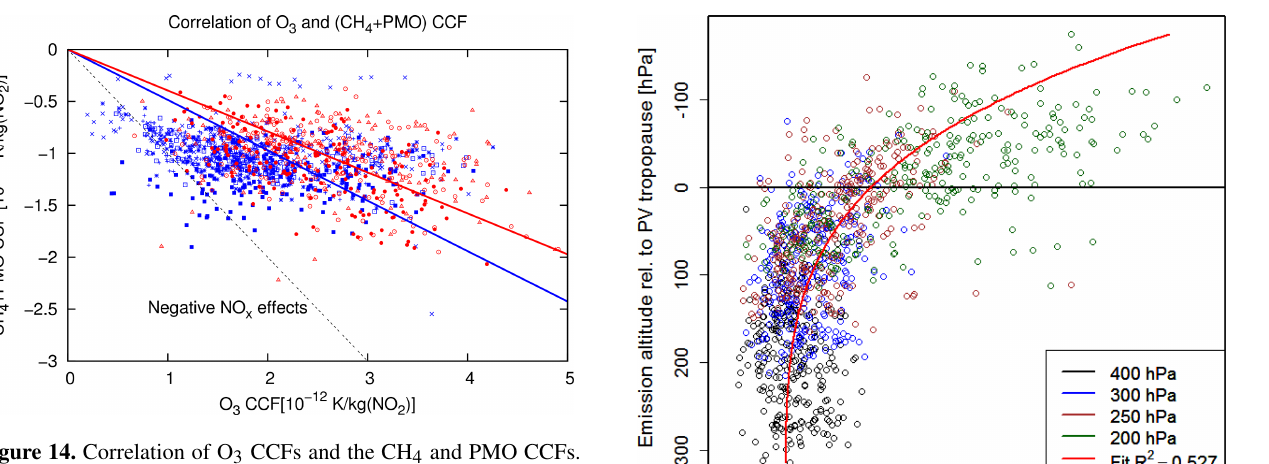
Figure 14. Correlation of O 3 CCFs and the CH 4 and PMO CCFs. The dashed line indicates the transition where the total NO x effect becomes negative. The symbols indicate the different weather pat- terns (blue is winter; red is summer). The blue and red lines show a linear fit for winter and summer weather patterns, respectively.